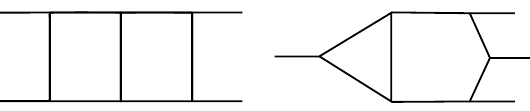
Figure 13 . Maximal two-loop